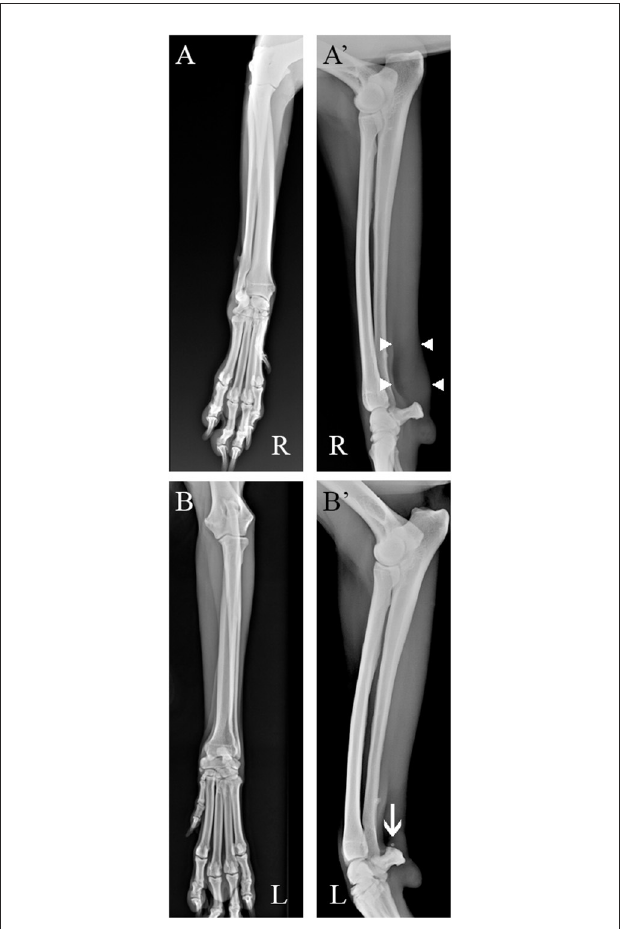
FIGURE1 Radiographic assessment of the patient (A) Right side. Soft tissues thickening in the projection area of the FCU tendon, proximal to the accessory carpal bone [ (A ′ ) , between white arrowheads] are detectable in the mediolateral standard view (B, B’) Left side. Entensiophites are detectable at the proximal pole of the accessory carpal bone (white arrow). No changes were detected on both craniocaudal standard views.